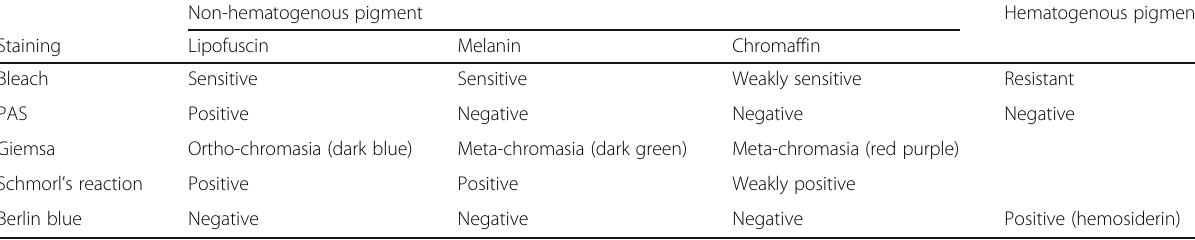
Table 2 Pigments and staining